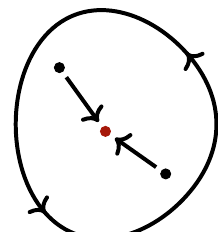
Figure 2. Two single poles that merge into a double pole for (cid:15) → 0 within a closed integration contour. The sum of their residues converges to the residue around the double